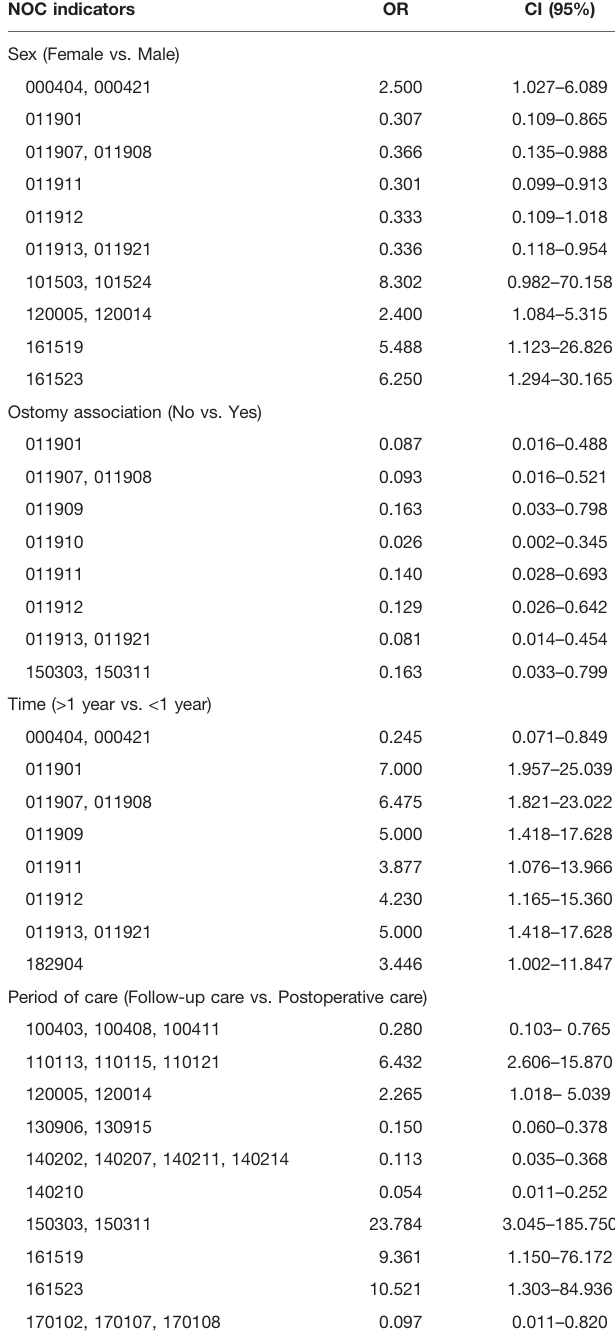
TABLE 3 | OR of signi fi cant NOC outcomes and their indicators vs. factors. NOC indicators OR CI (95%) Sex (Female vs.